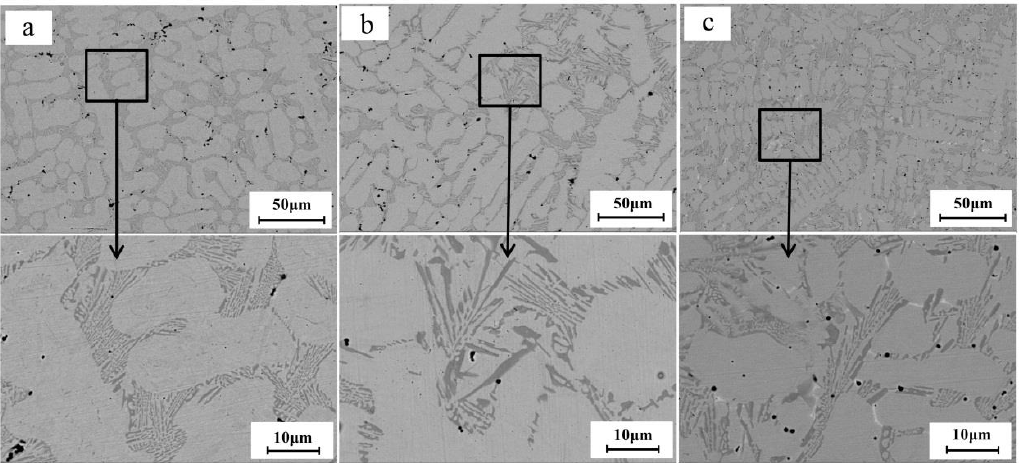
Figure 4. Surface carbide morphology of different surfacing layers. ( a ) 5Cr13; ( b ) 8Cr13; ( c ) 8Cr13MoV.